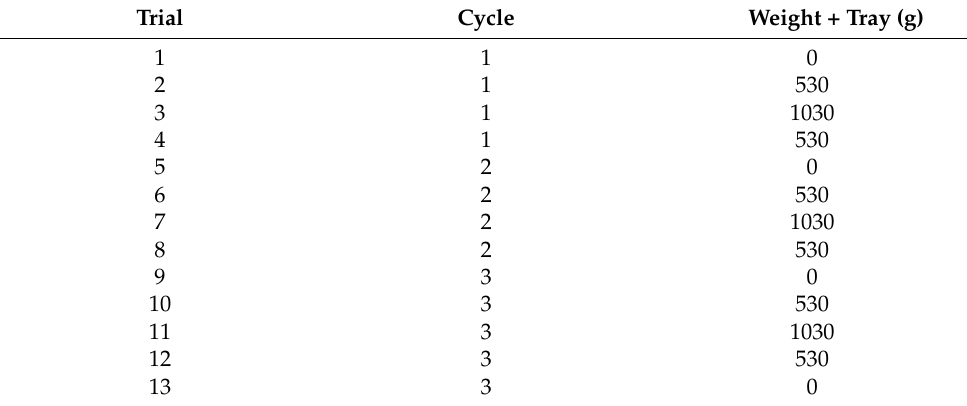
Table 4. Loading cycle trials for a single loading direction. The mass of the tray was 230 grams. Trial